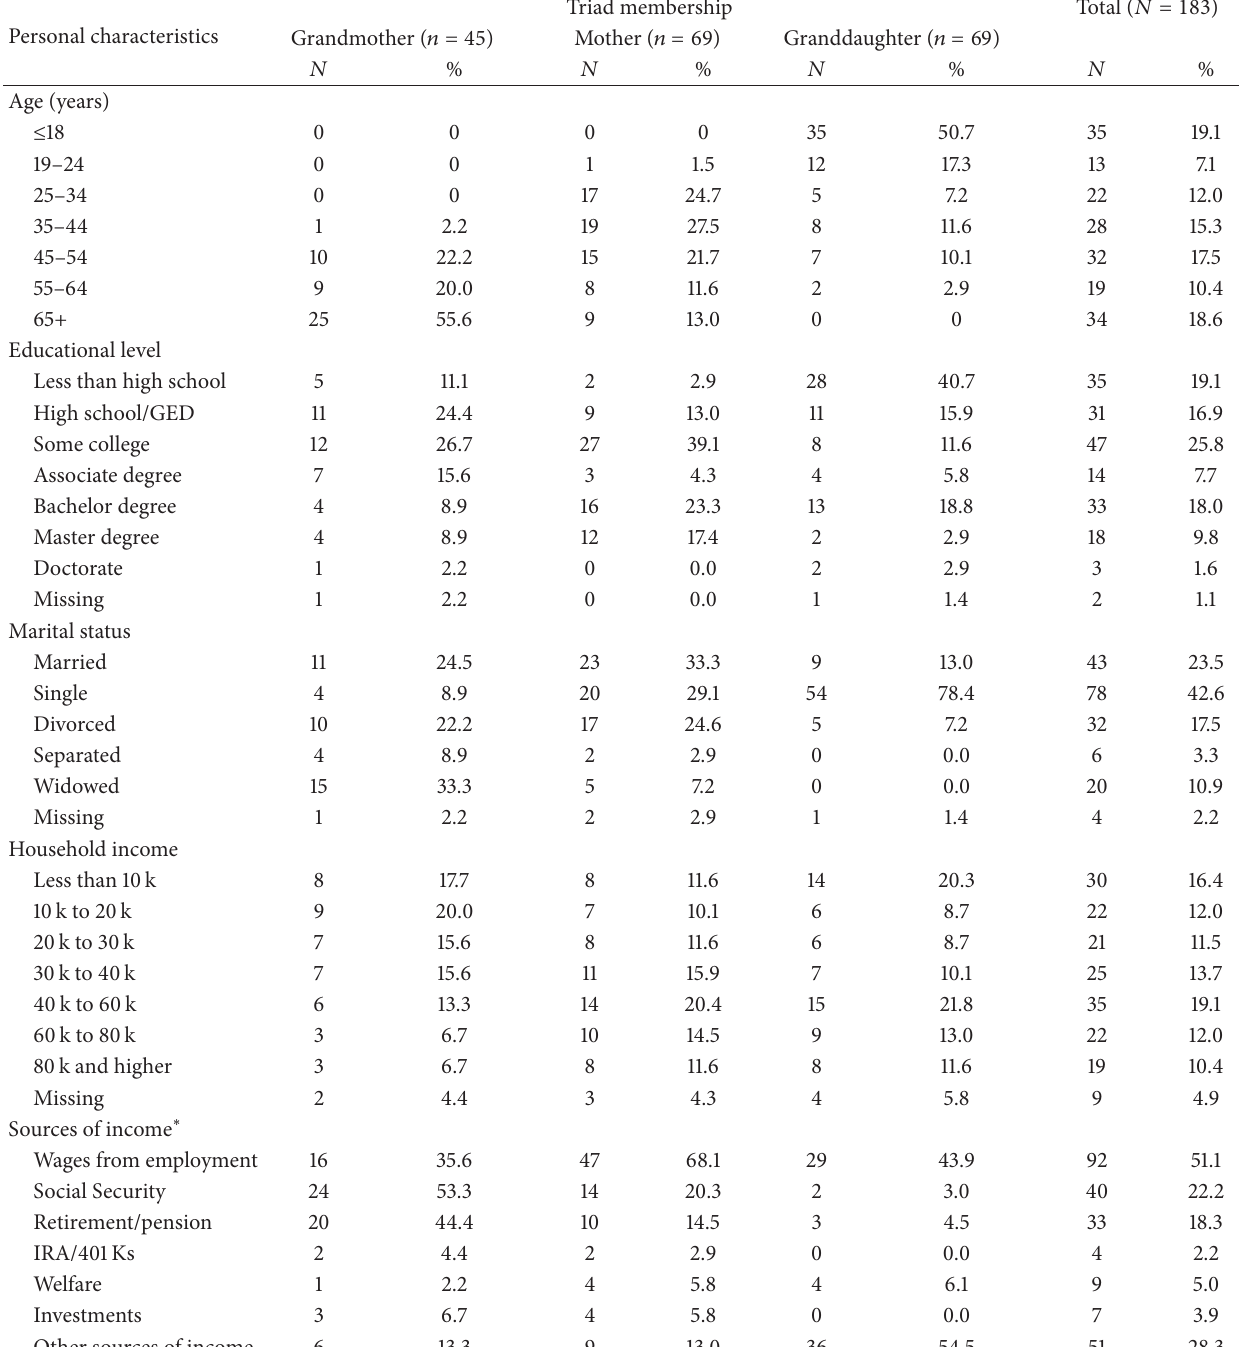
Table 2: Personal characteristics by triad